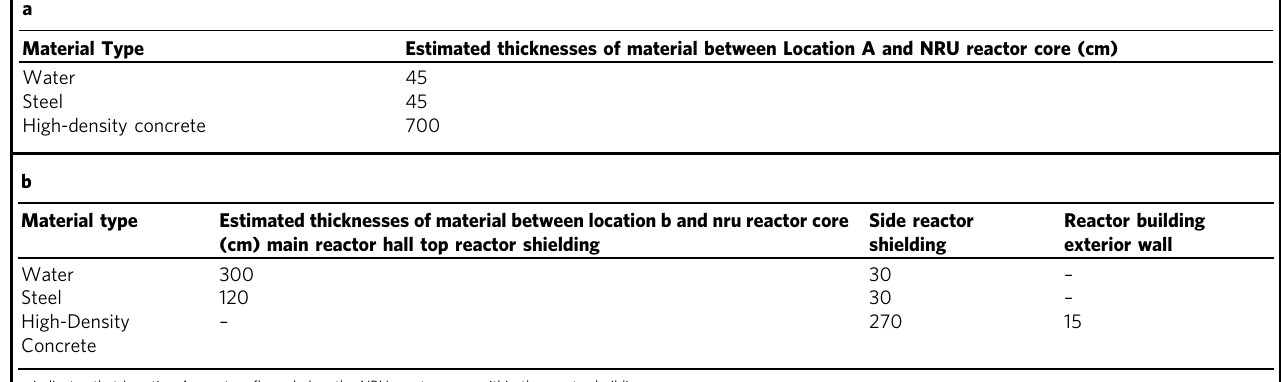
a indicates that Location A was two fl oors below the NRU reactor core, within the reactor building b indicates that LocationB was at ground level outside of the reactor building. The main reactor hallwas at ground level,enclosed by the reactor building exterior walls.The main reactor hallsurrounded the top and side shielding of the reactor